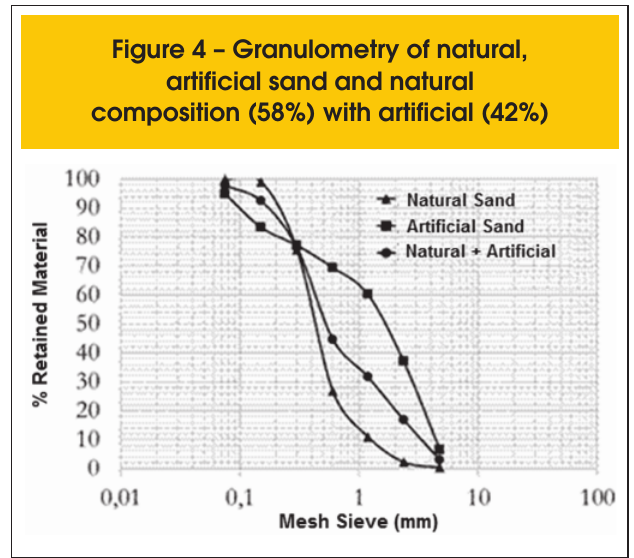
Figure 4 – Granulometry of natural, artificial sand and